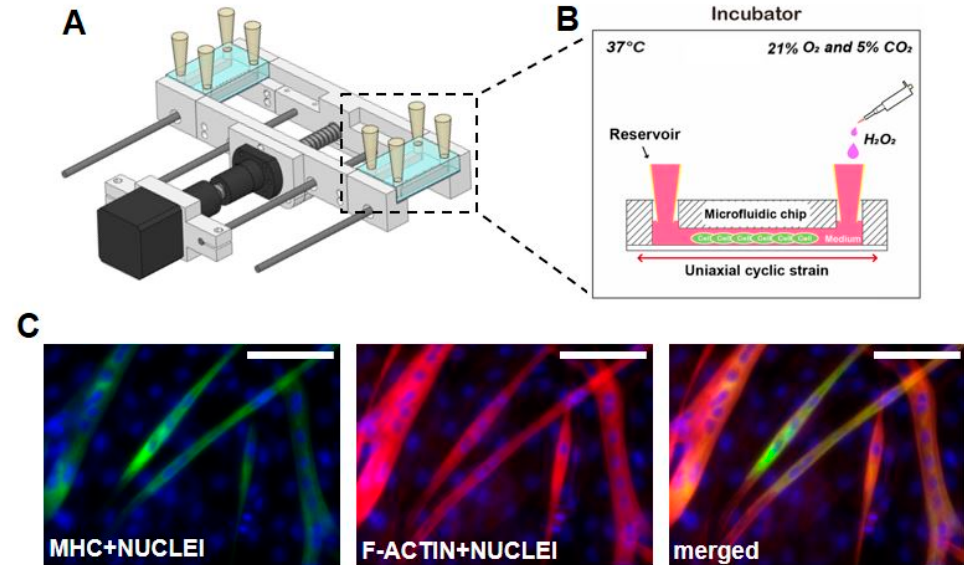
Figure 1. Stretchable microfluidic platform for inducing damage and recovery on skeletal muscle cells. ( a ) Schematic diagram of the lab-made stretcher with microfluidic chip and ( b ) detailed view of microfluidic chip is shown. The entire setup is placed in the incubator during experiments. The reservoir is filled with growth medium (GM) for the first 2 h after seeding and later supplemented with differentiation medium (DM). ( c ) Skeletal muscle differentiation is confirmed with immunofluorescence imaging of Myosin Heavy Chain (MHC) (green) and the presence of multi-nucleated C2C12 cells in microfluidic chip for 4 days after seeding. F-actin was stained with rhodamine-phalloidin (red), nuclei were stained with 4 ′ ,6-diamidino-2-phenylindole (DAPI) (blue), and merged shows the overlaid fluorescent image. (scale bar: 50 µm)